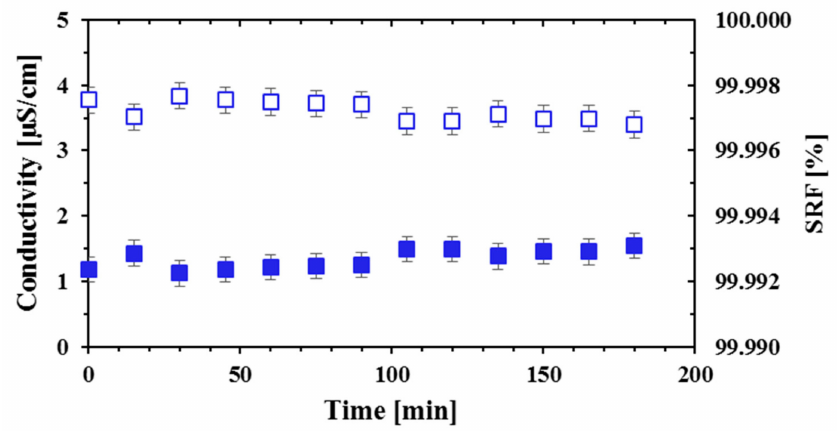
Figure 3. Permeate conductivity and SRF obtained with the module Oryx 150 after cleaning with demineralized water at 80 ◦ C. Blue squares: conductivity, blue empty squares: